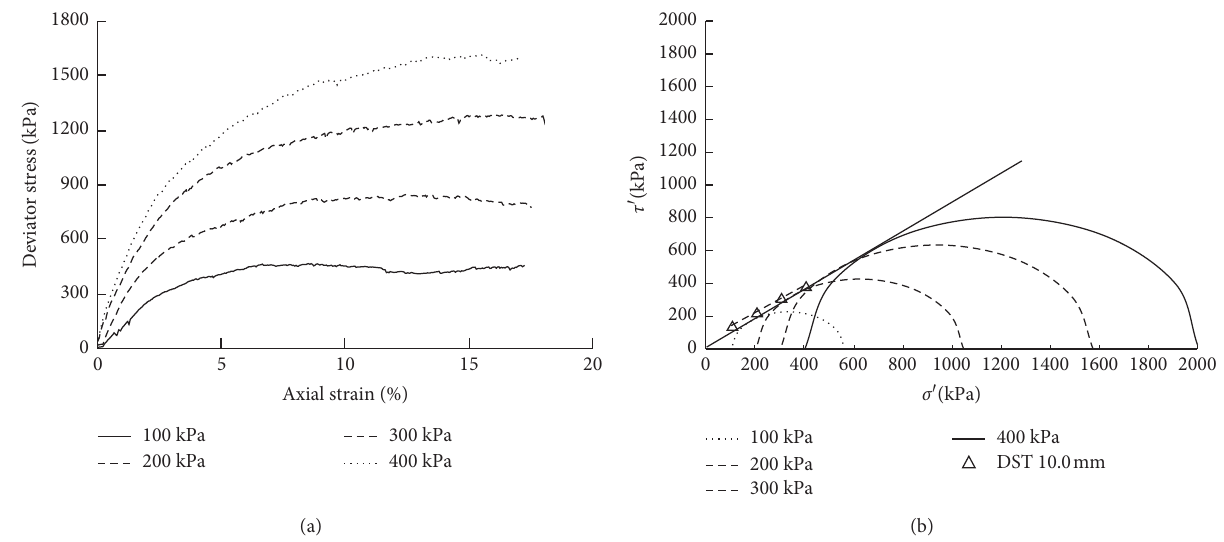
Figure 15: (a) Variation of deviatoric stress with axial strain for G3. (b) Comparison of shear strengths determined by direct shear test (plate opening 10.0mm) and triaxial tests for G3.